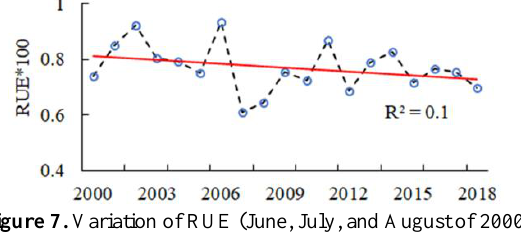
Figure 7. Variation of RUE (June, July, and August of 2000- 2018).